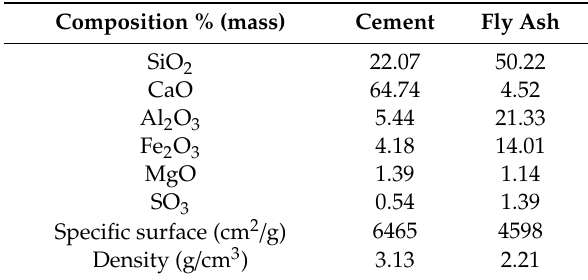
Table 2. Chemical and physical information of cement and fly ash.